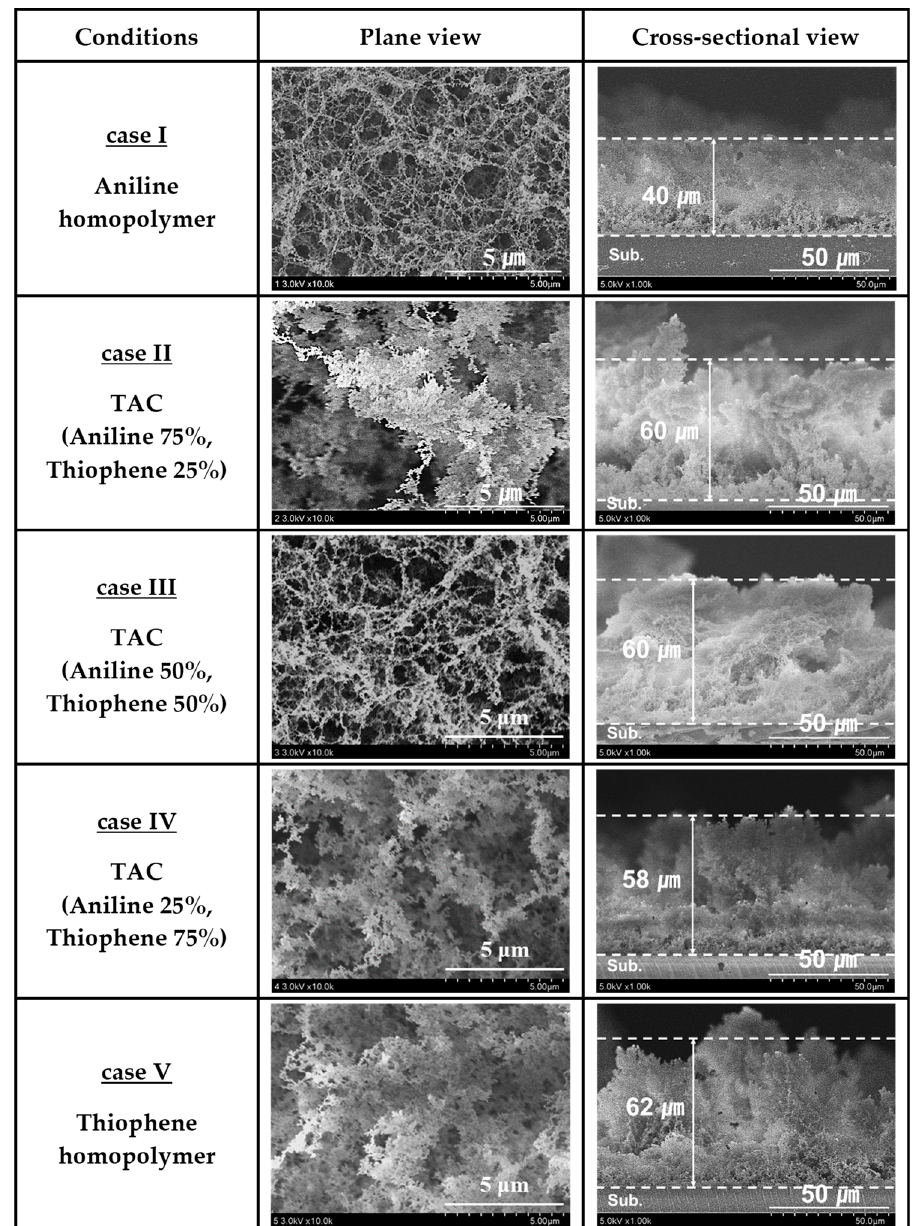
Figure 3. Plane and cross-sectional FE-SEM images of TAC films including PANI and PTh films deposited on glass substrates by APPJs polymerization relative to various ratios of blended solutions of aniline and thiophene monomers.